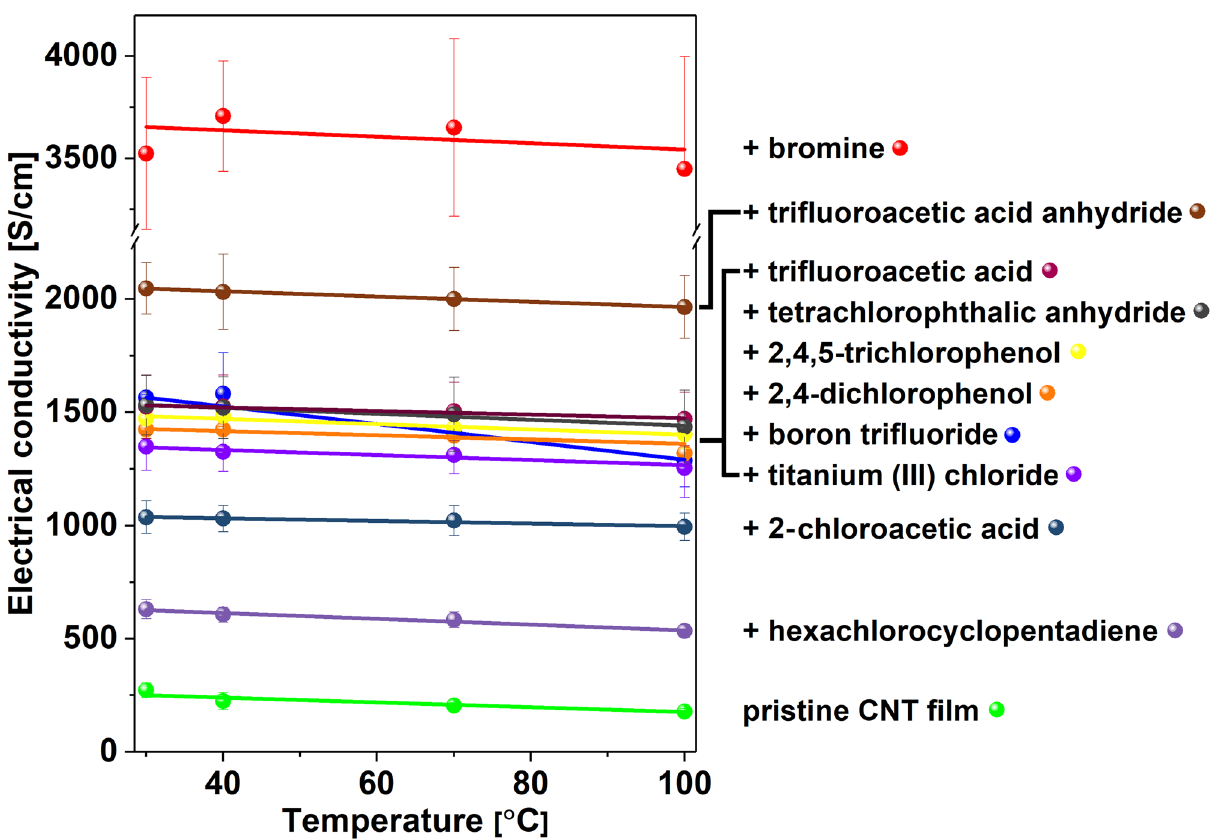
Figure 4. Electrical conductivity at different temperatures for a pristine CNT film and CNT films after doping with halide compounds. Lines were added to guide the eye through a selected group of